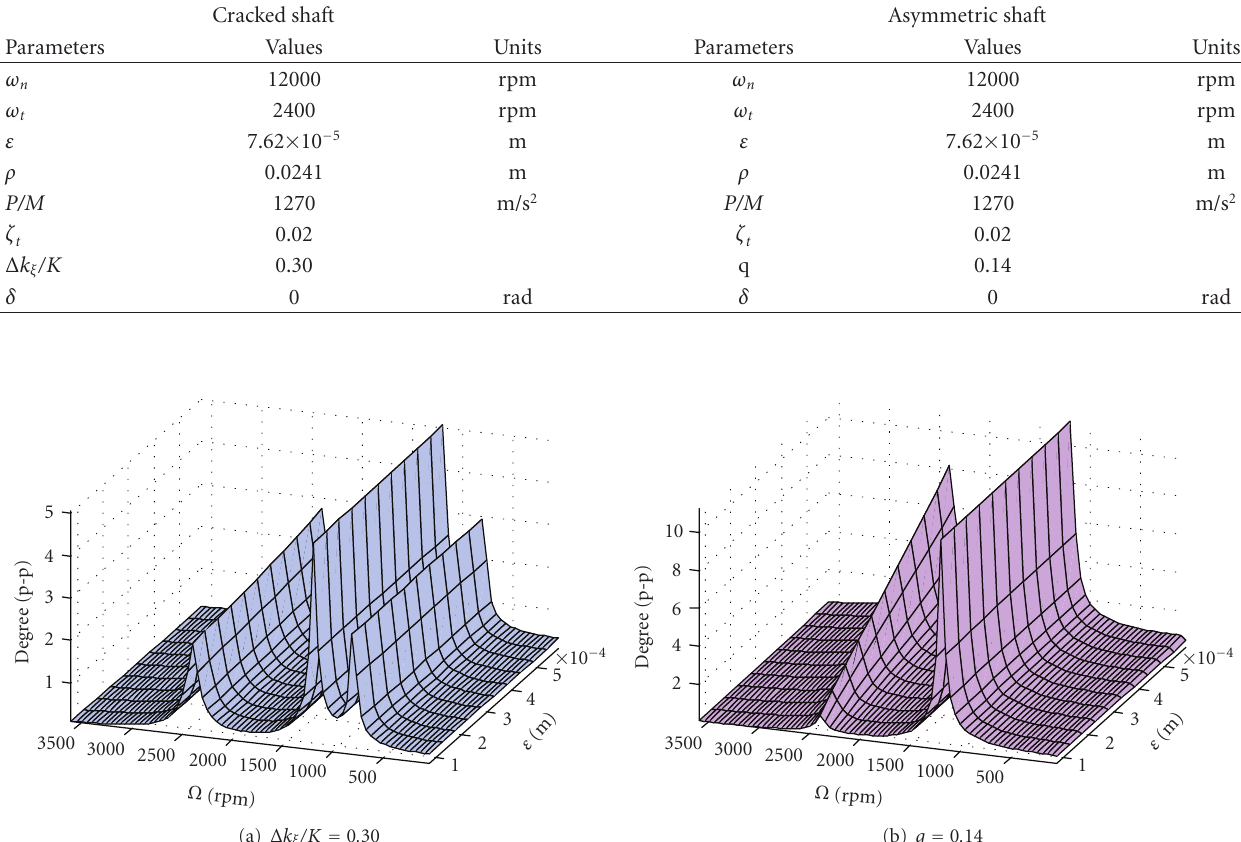
Figure 4: Overall peak-to-peak torsional vibration response, ϕ , special cases, for cracked shaft (a) and asymmetric shaft (b).